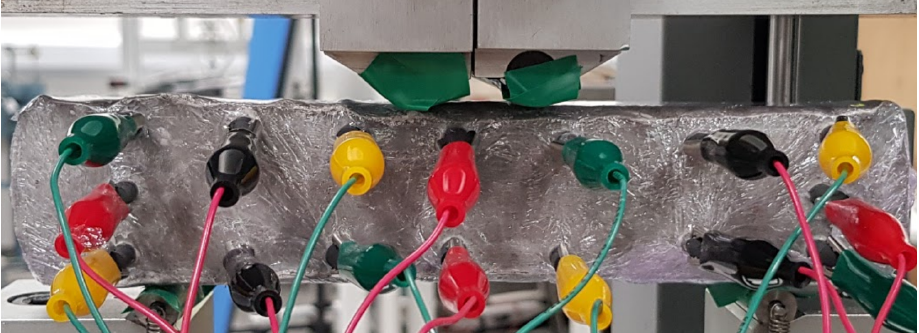
Figure 7. Small-scale beam bending experimental setup, with 16 electrodes interrogating an AAM patch on the concrete surface. Green tape was used to insulate the loading machine from the